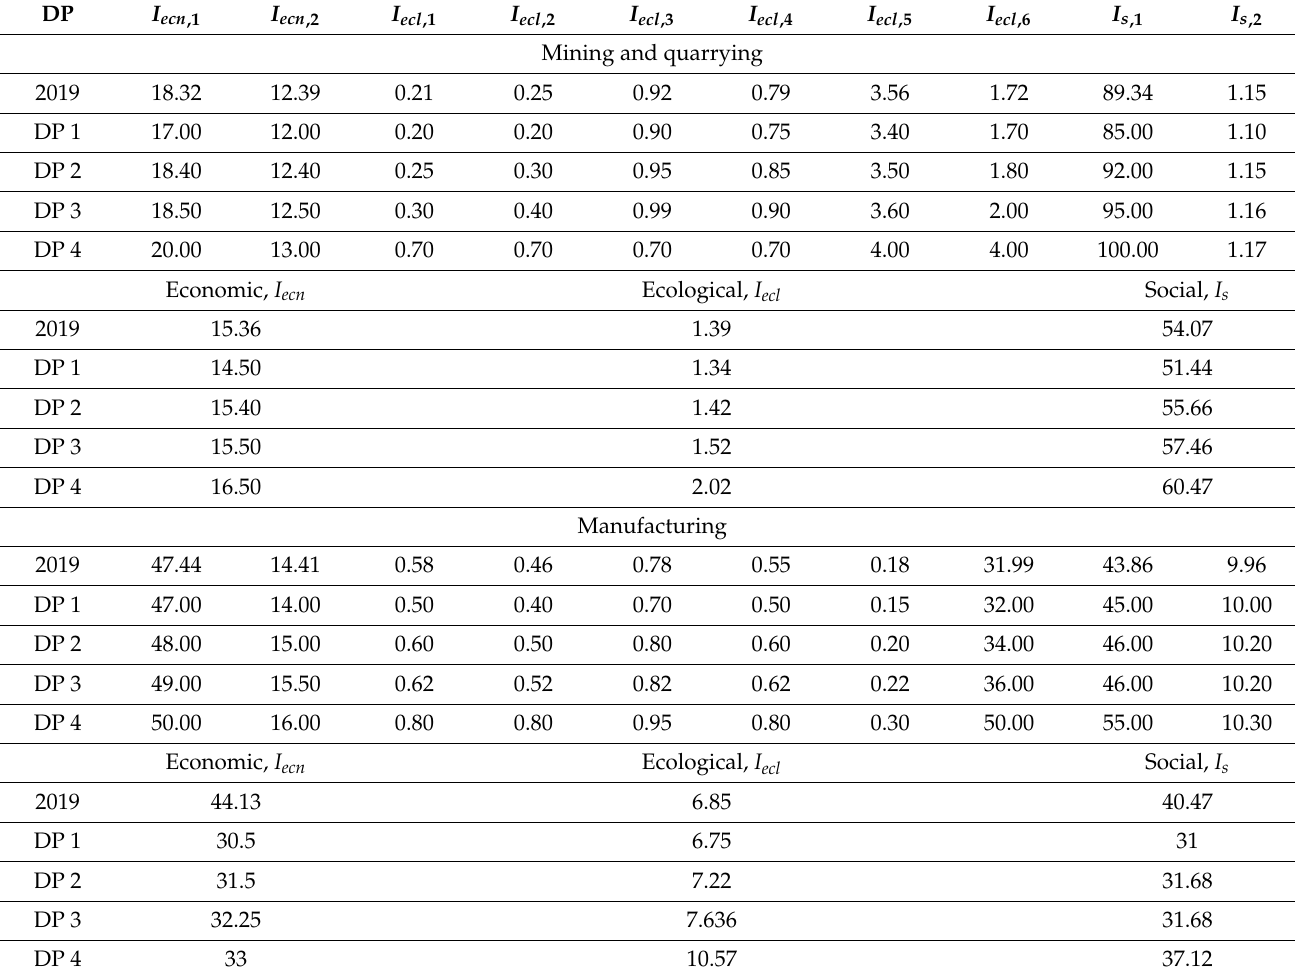
Table 6. Indicators of alternative directions of industrial development in